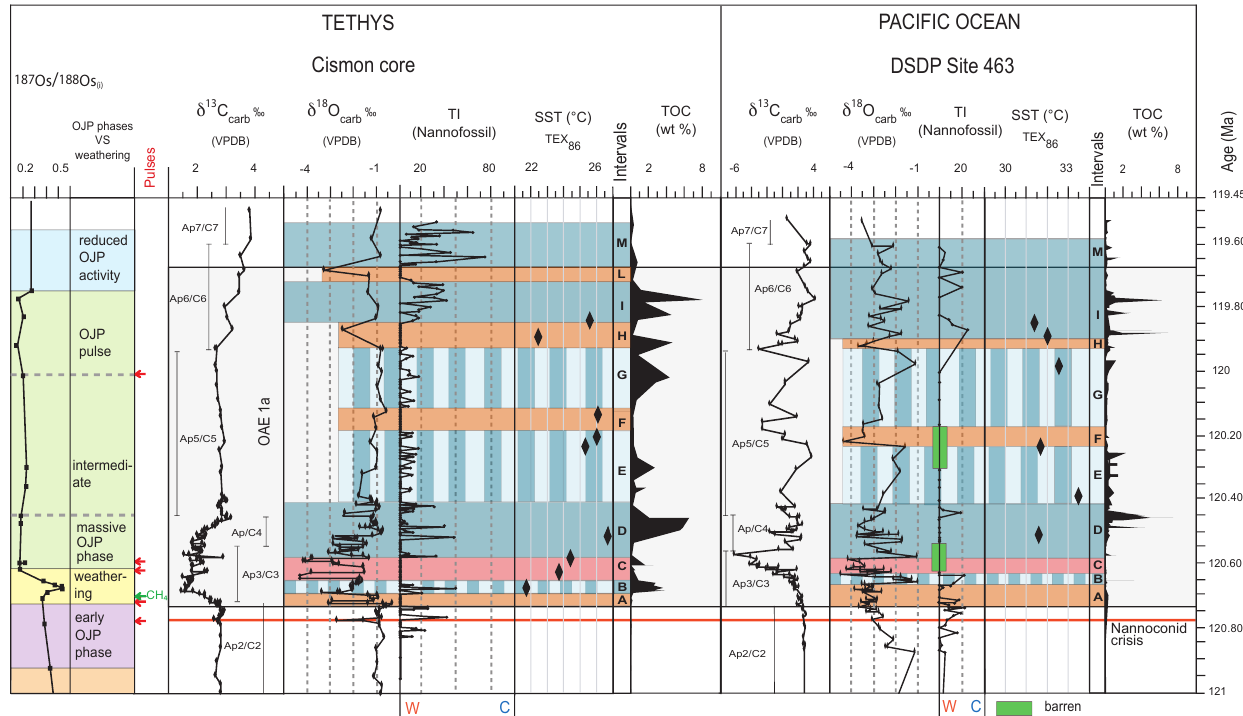
Figure 8. Nannofossil temperature index (TI), TEX 86 and oxygen-isotope values for the Cismon core and DSDP Site 463 plotted against chemostratigraphy. The age determination is based on the cyclochronology available for the Cismon core (Malinverno et al., 2010). δ 13 C data after Erba et al. (1999) and Méhay et al. (2009) for the Cismon core; Price (2003), Ando et al. (2008) and Bottini et al. (2012) for DSDP Site 463. Bulk δ 18 O data after Erba et al. (2010) for the Cismon core; Price (2003), Ando et al. (2008) and this work for DSDP Site 463. TOC after Erba et al. (1999) and Bottini et al. (2012) for the Cismon core; Ando et al. (2008) for DSDP Site 463. TEX 86 after Schouten et al. (2003) for DSDP Site 463; this work for the Cismon core (SST calculated using the equation of Kim et al., 2010). The Os-isotope curve (Bottini et al., 2012) is reported on the left, as well as the volcanogenic CO 2 pulses (red arrows) reconstructed by Méhay et al. (2009) and Erba et al. (2010). The intervals A–M represent the climatic interludes (warming and cooling) reconstructed in this